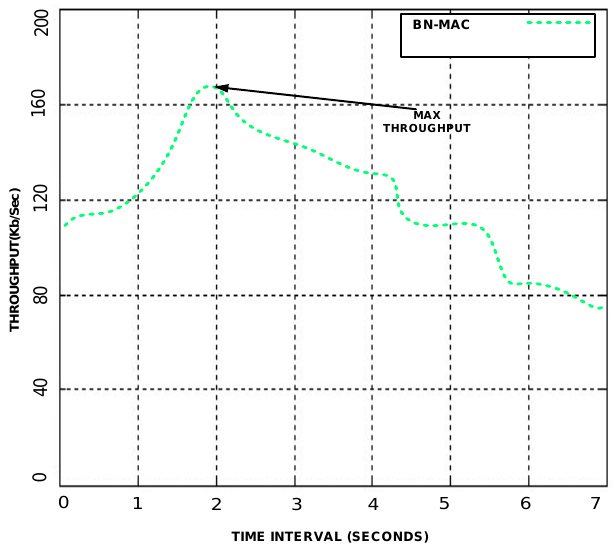
Figure 2. Throughput at different time intervals.